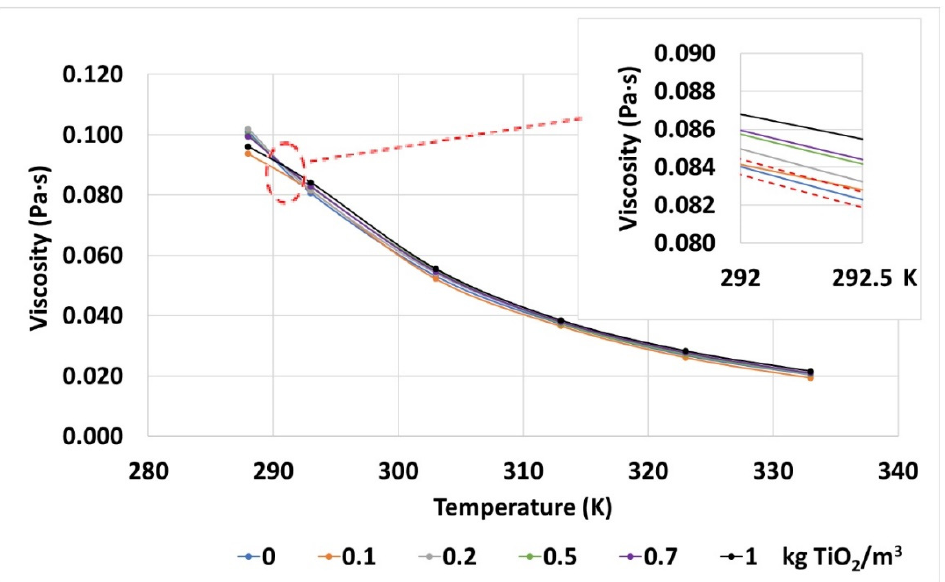
Figure 8. Dynamic viscosities measured for the base fluid and TiO 2 nanofluids at different temperatures. The error gaps of the measurements are also shown by red dashed lines in the inset, top-right corner.